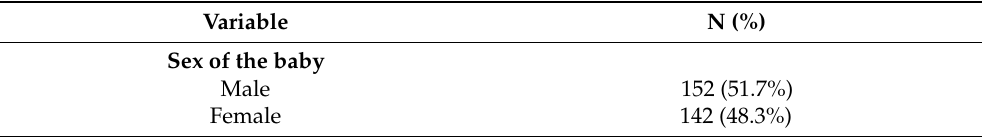
Table 1. Sociodemographic characteristics of the